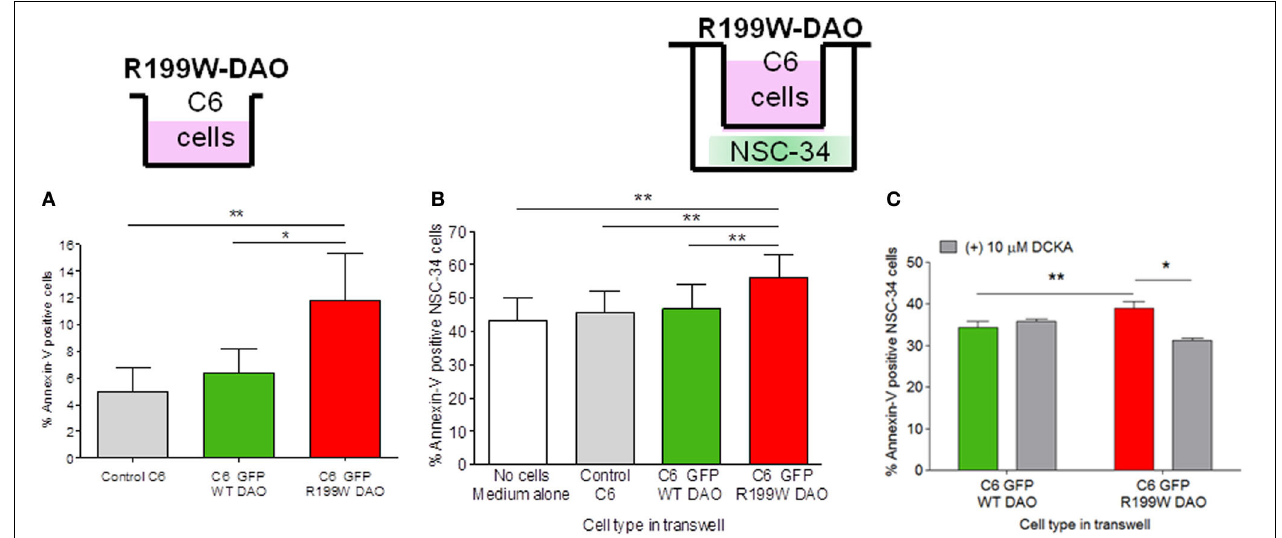
FIGURE 1 | R199W DAO promotes apoptosis in glial cells and neighboring neuronal cells. Annexin V levels in (A) C6 glial cells permanently expressing WT or R199W DAO, (B) NSC-34 neuronal cells co-cultured with C6 glial cells, (C) NSC-34 cells treated with DCKA co-cultured with C6 cells and immunoblotted and quantified. Significant One-Way ANOVA subject to